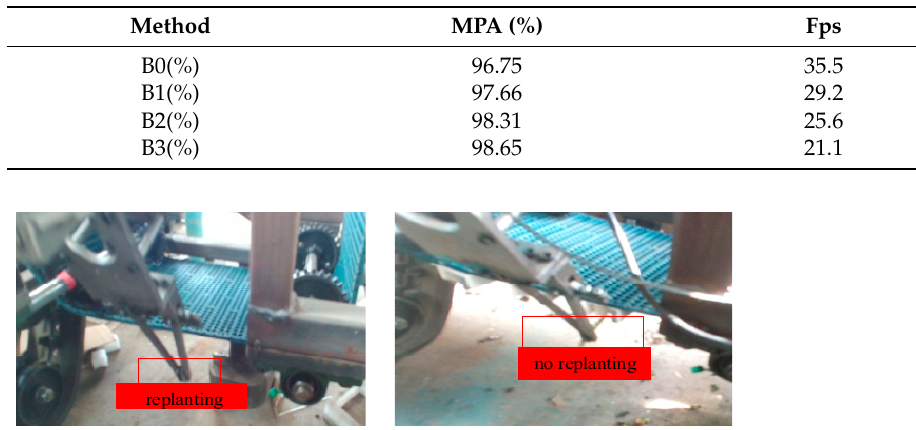
Figure 16. Sweet potato seedlings recognition results.